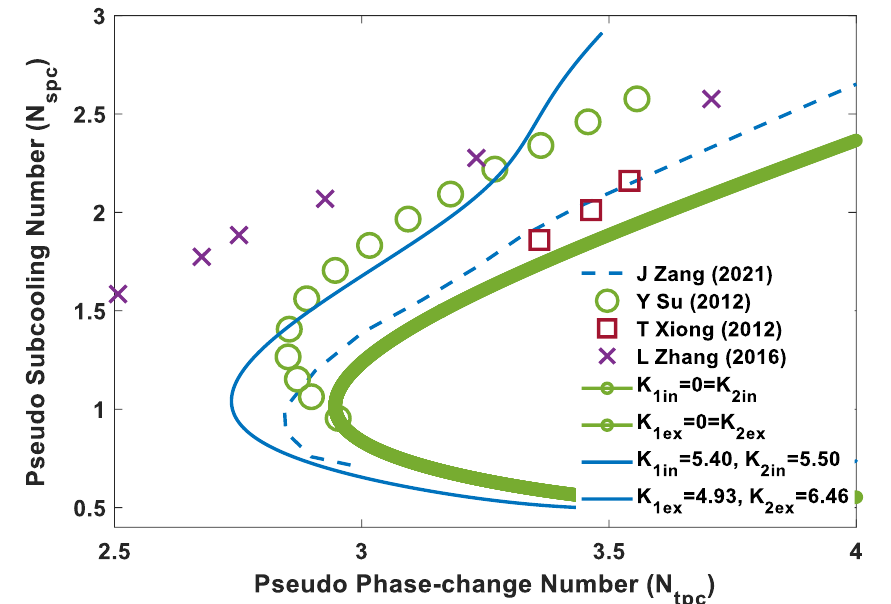
Figure 7. Comparison stability threshold in the N tpc − N spc space with different literature data.